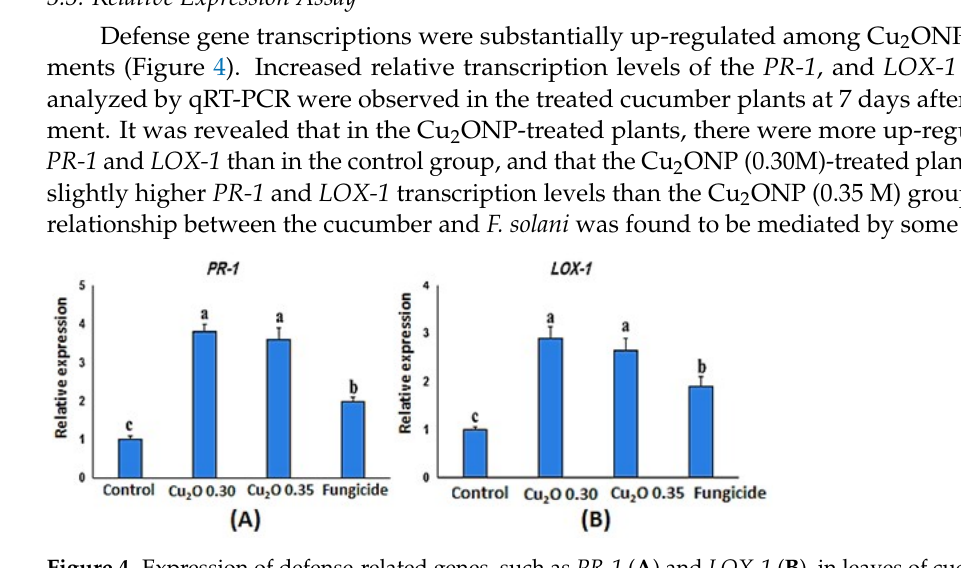
Figure 4. Expression of defense-related genes, such as PR-1 ( A ) and LOX-1 ( B ), in leaves of cucumber plants treated with Cu 2 ONPs before challenge inoculation with F. solani